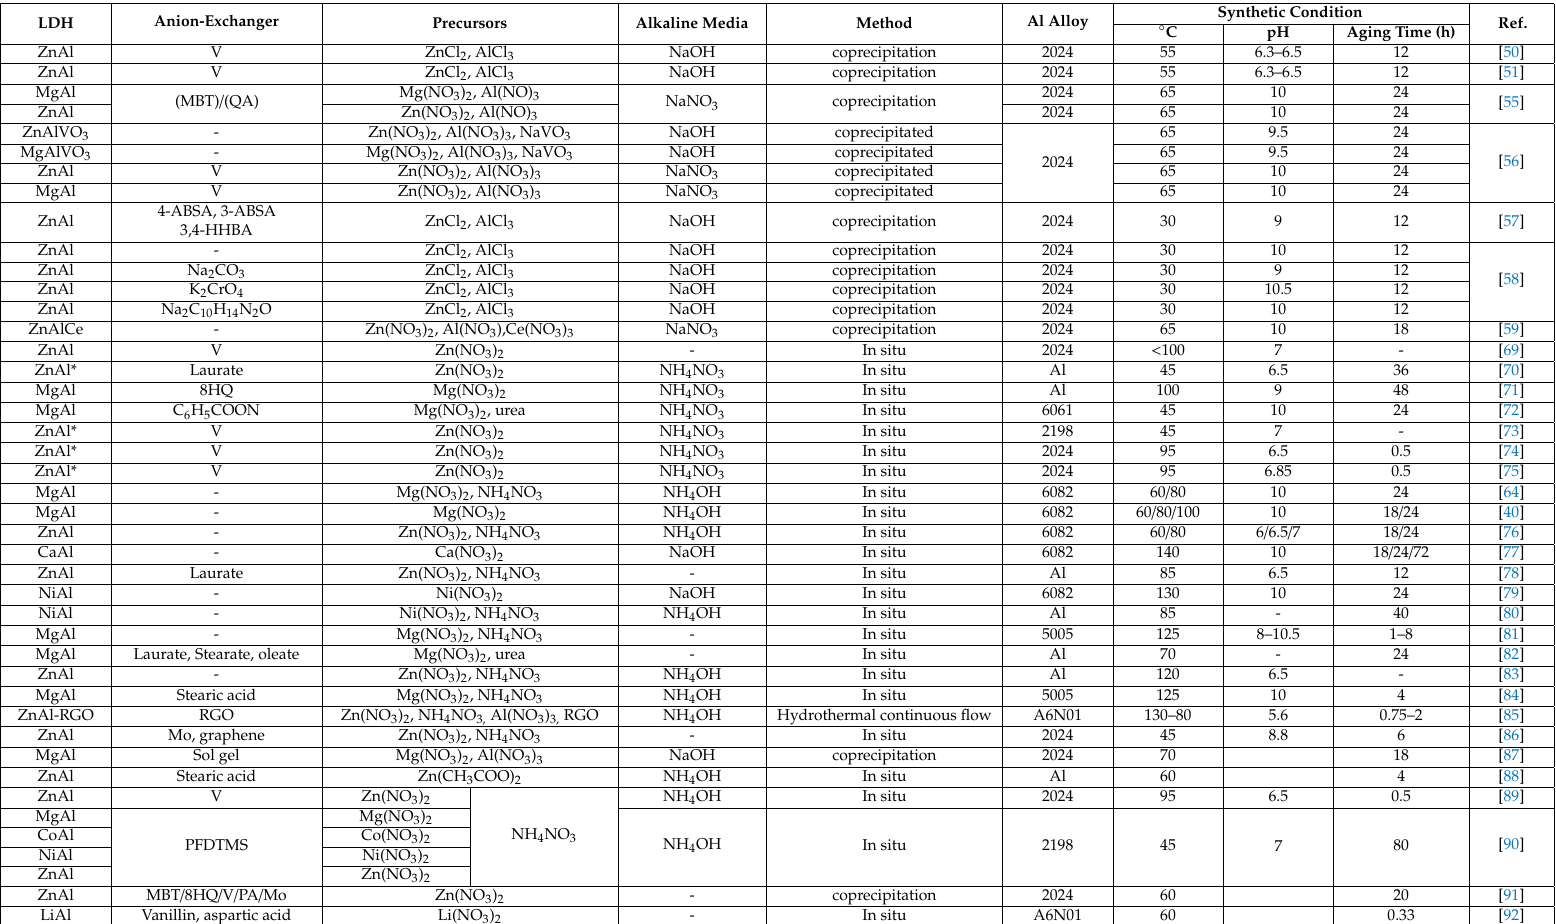
Table 1. Synthesis approaches to LDHs at various synthetic conditions with various